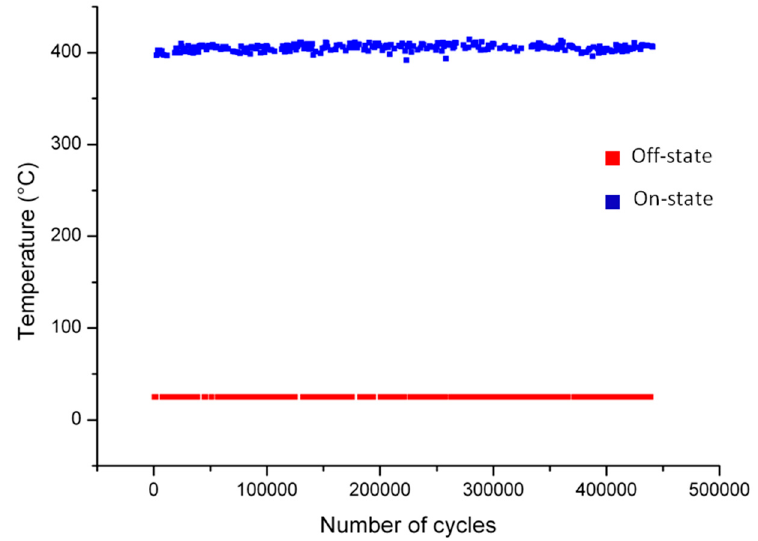
Figure 13. Long term on/off cycling test on the fabricated devices.